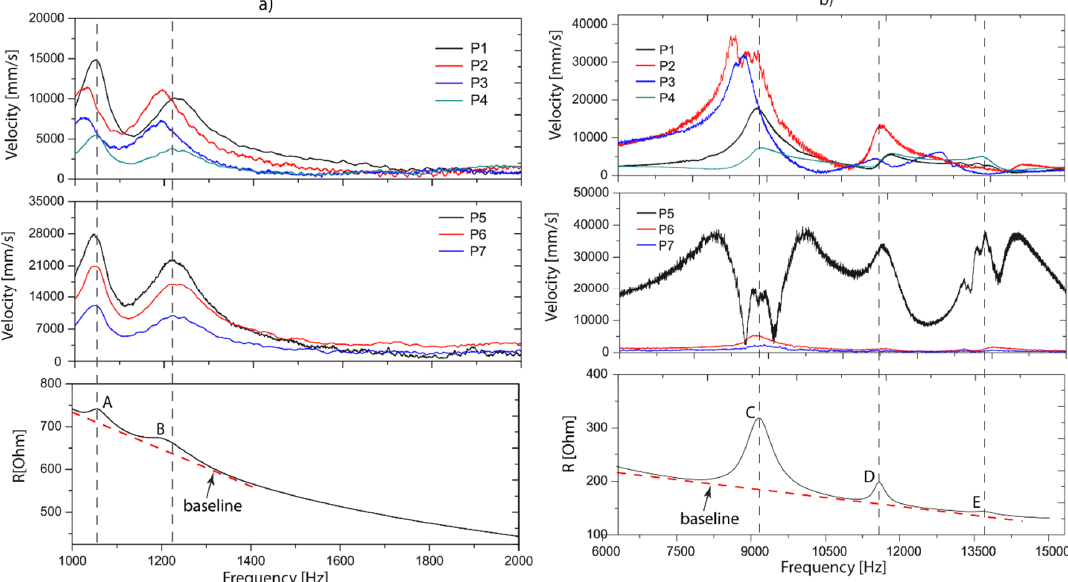
Figure 6. Comparison between velocity and electrical resistance, ( a ) 1–2 kHz. ( b ) 6–15 kHz.